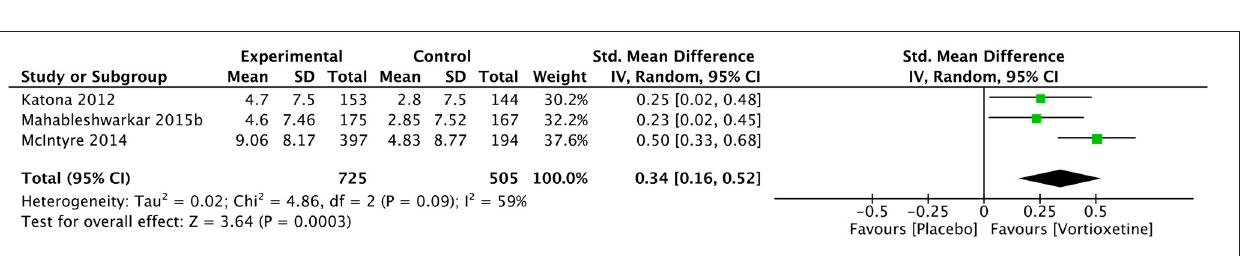
FIGURE 5 | Forest plot of comparison on cognitive function on vortioxetine vs.